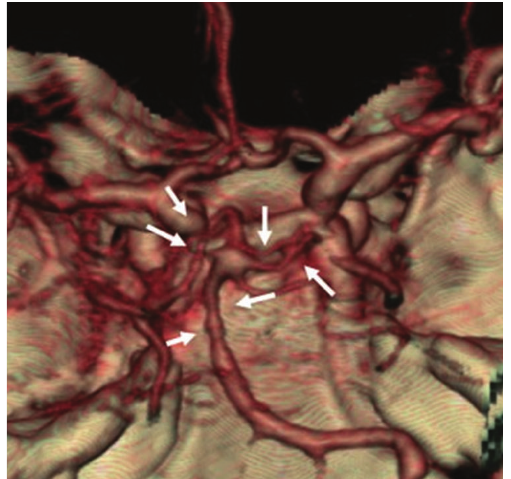
F 4: CT Angiography. ree-dimensional reconstruction shows severe vasospasm of the distal basilar artery and bilateral PCAs adapted from [1].